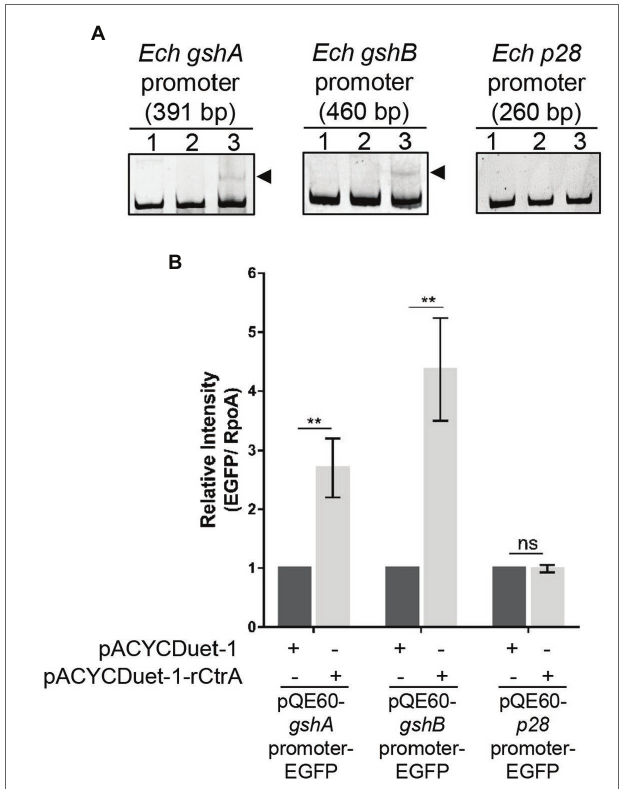
FIGURE 5 | CtrA binds to the promoter regions of gshA and gshB and activates their expression. (A) CtrA binds to the promoter regions of gshA and gshB . DNA probe (50 ng) was incubated alone (lane 1), with GST (2.5 μ M, lane 2), or with GST-rCtrA (2.5 μ M, lane 3) on ice for 30 min. Shifted bands are indicated by arrowheads. The p28 promoter is shown as a negative control. The length (bp) of the probe is shown above each panel. (B) CtrA activates the expression of gshA and gshB . Escherichia coli BL21(DE3) strains grown to an OD 600 of 0.4 were induced to express rCtrA with 0.05 mM IPTG at 37 ° C for 3 h. The amount of enhanced green fluorescent protein (EGFP) or RpoA was determined using Western blotting. The relative intensities of EGFP to those of RpoA were measured by Image J and calculated by setting the value of bacteria containing pACYCDuet-1 and corresponding pQE60-promoter- EGFP fusion construct as 1. Data indicate means ± standard deviations ( n = 3). The significant differences are represented by p -values determined with Student’s t -test (ns indicates p > 0.05, ** p <